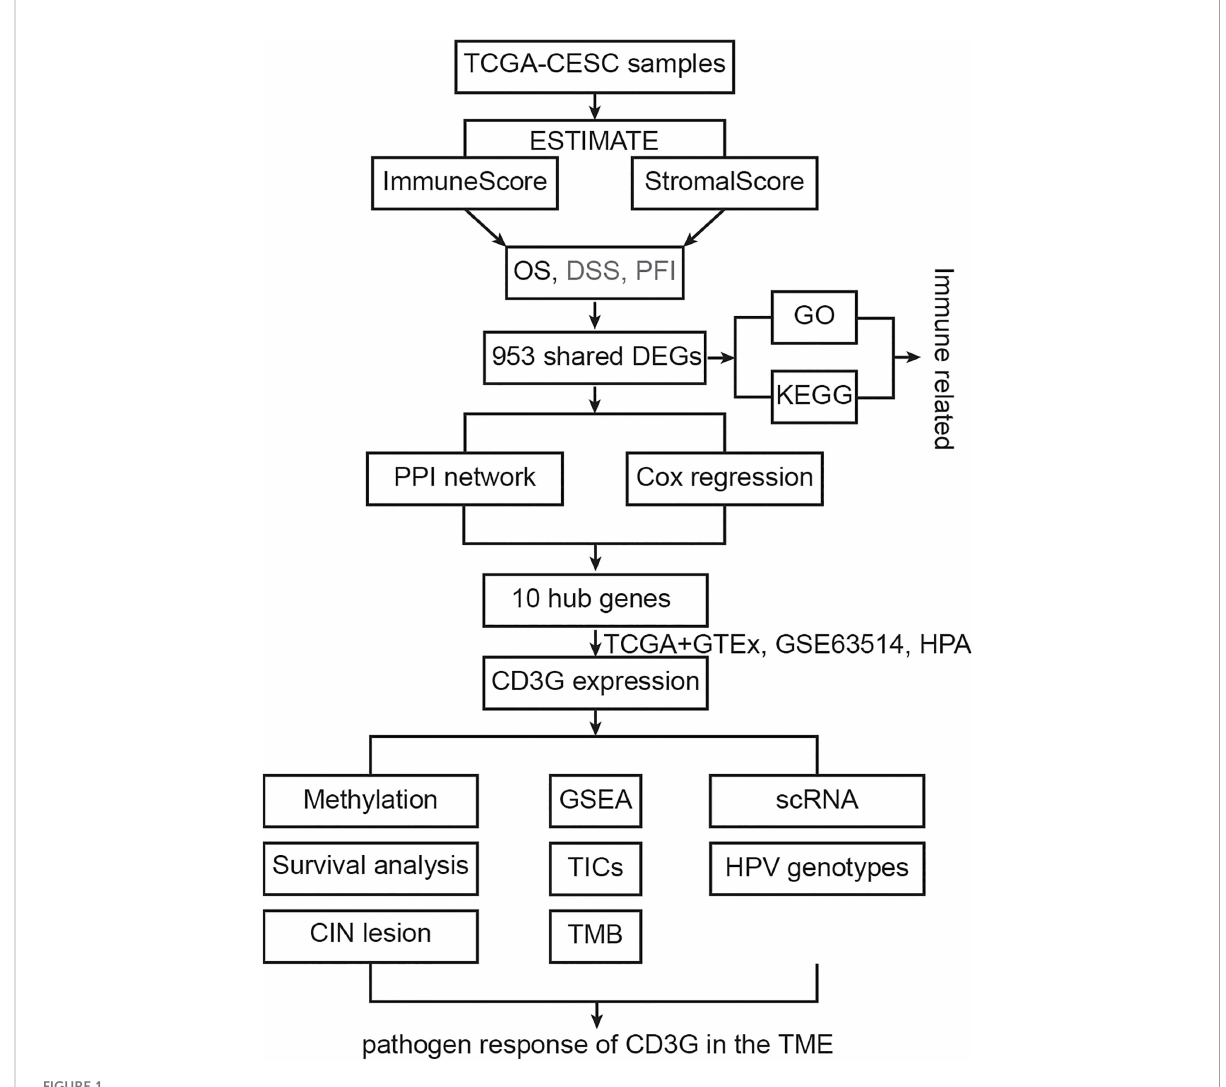
FIGURE 1 The fl owchart showing the process of this